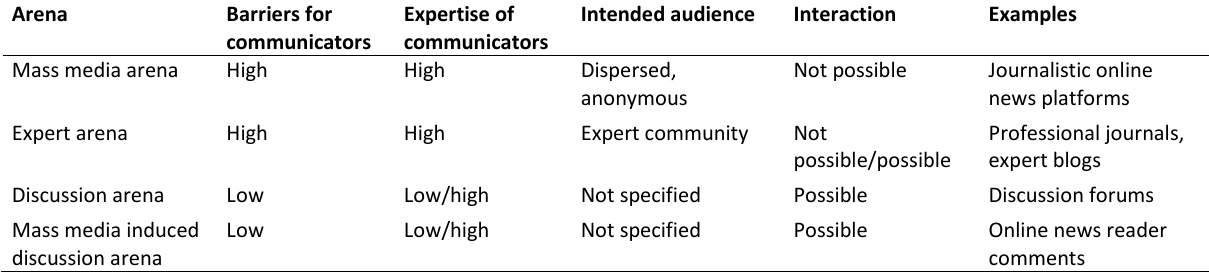
Table 2. Online public arenas (based on Schmidt